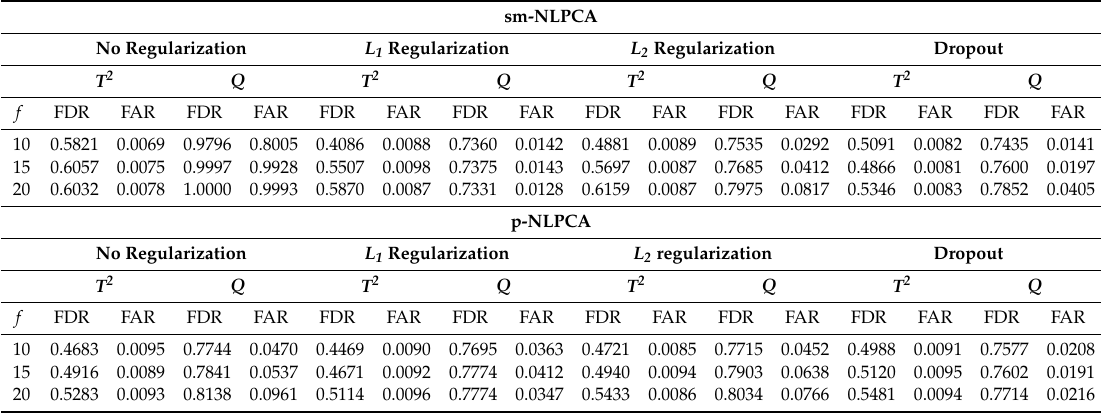
Table 8. Process monitoring results with neural network regularization (Network Type 4).